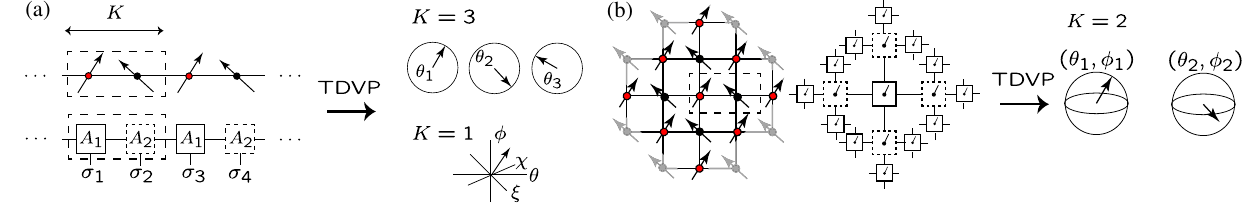
FIG. 1. (a) The state of a quantum system that is short-range entangled and translationally invariant with a unit cell of size K can be described by an MPS with the same size of unit cell. (b) The wave function of the square lattice is approximated by a TTS in the form of a Cayley tree with connectivity C ¼ 4 . The state with K ¼ 2 unit cell is described by a tree where two different tensors